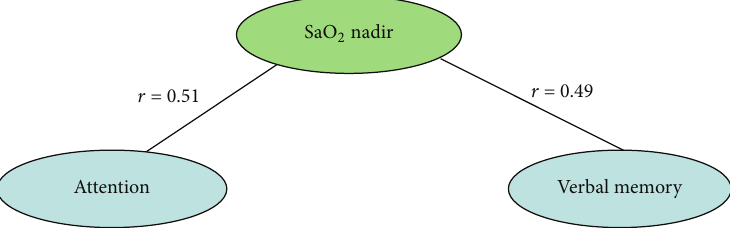
Figure 2: Spearman correlations between sleep parameters and cognitive measures are shown for hypertensive non-OSA patients. As can be seen, middle statistically significant correlations were found between the verbal memory-SaO 2 nadir ( 𝑟 = 0.49 , 𝑃 < 0.05 ) and the attention- SaO 2 nadir ( 𝑟 = 0.51 , 𝑃 < 0.05